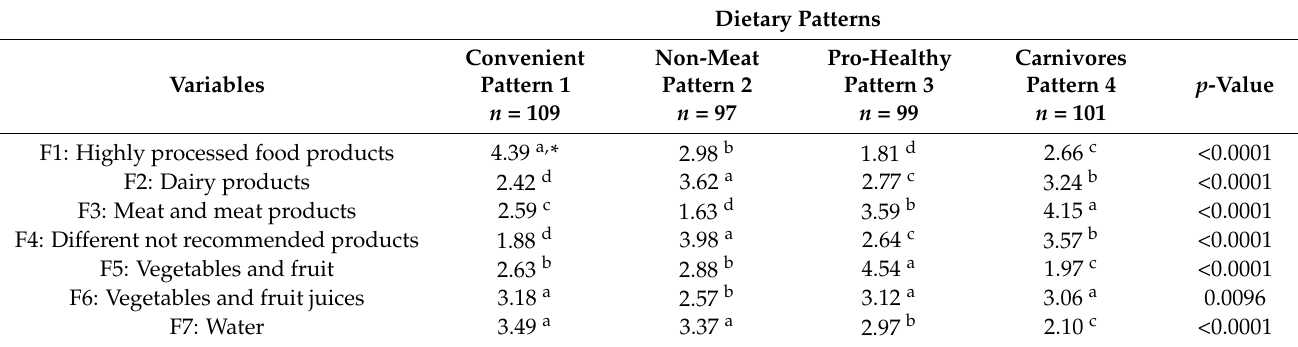
Table 2. Characteristics of the identified patterns according to the consumption frequency; the mean ratings of the patterns on the classification